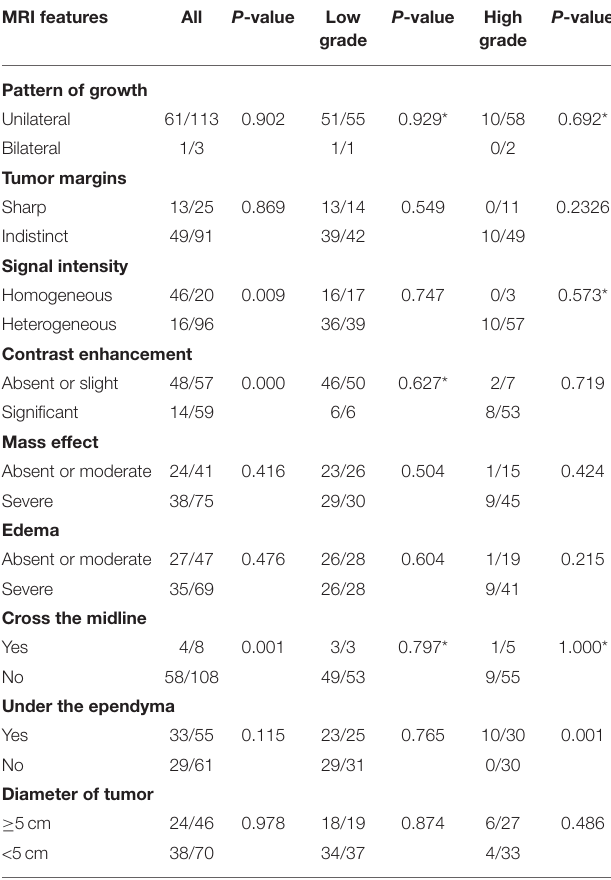
TABLE 1 | Correlation between IDH1 mutation and MRI features of